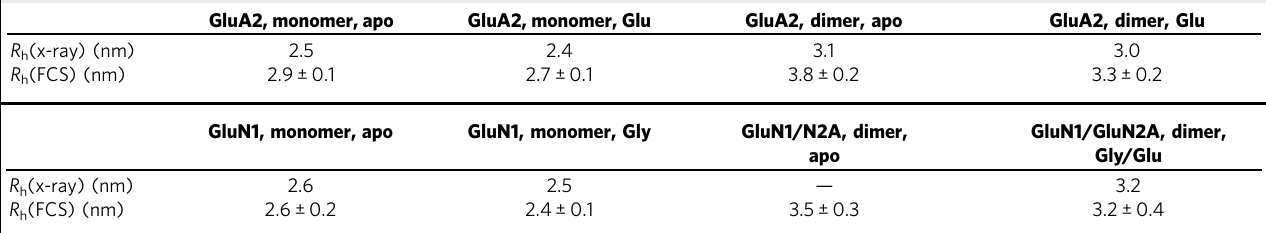
Table 2 Hydrodynamic radii of AMPA and NMDA LBDs measured using FCS and compared with values calculated from available x-ray